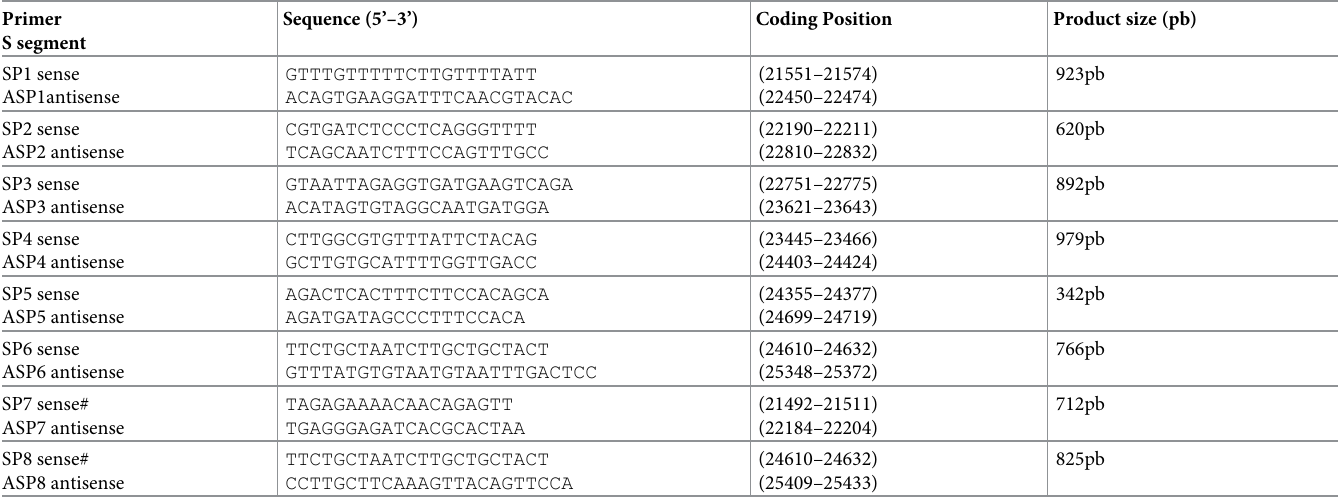
Table 2. List of primers used for the S gene amplification of SARS-CoV-2. Primer S segment